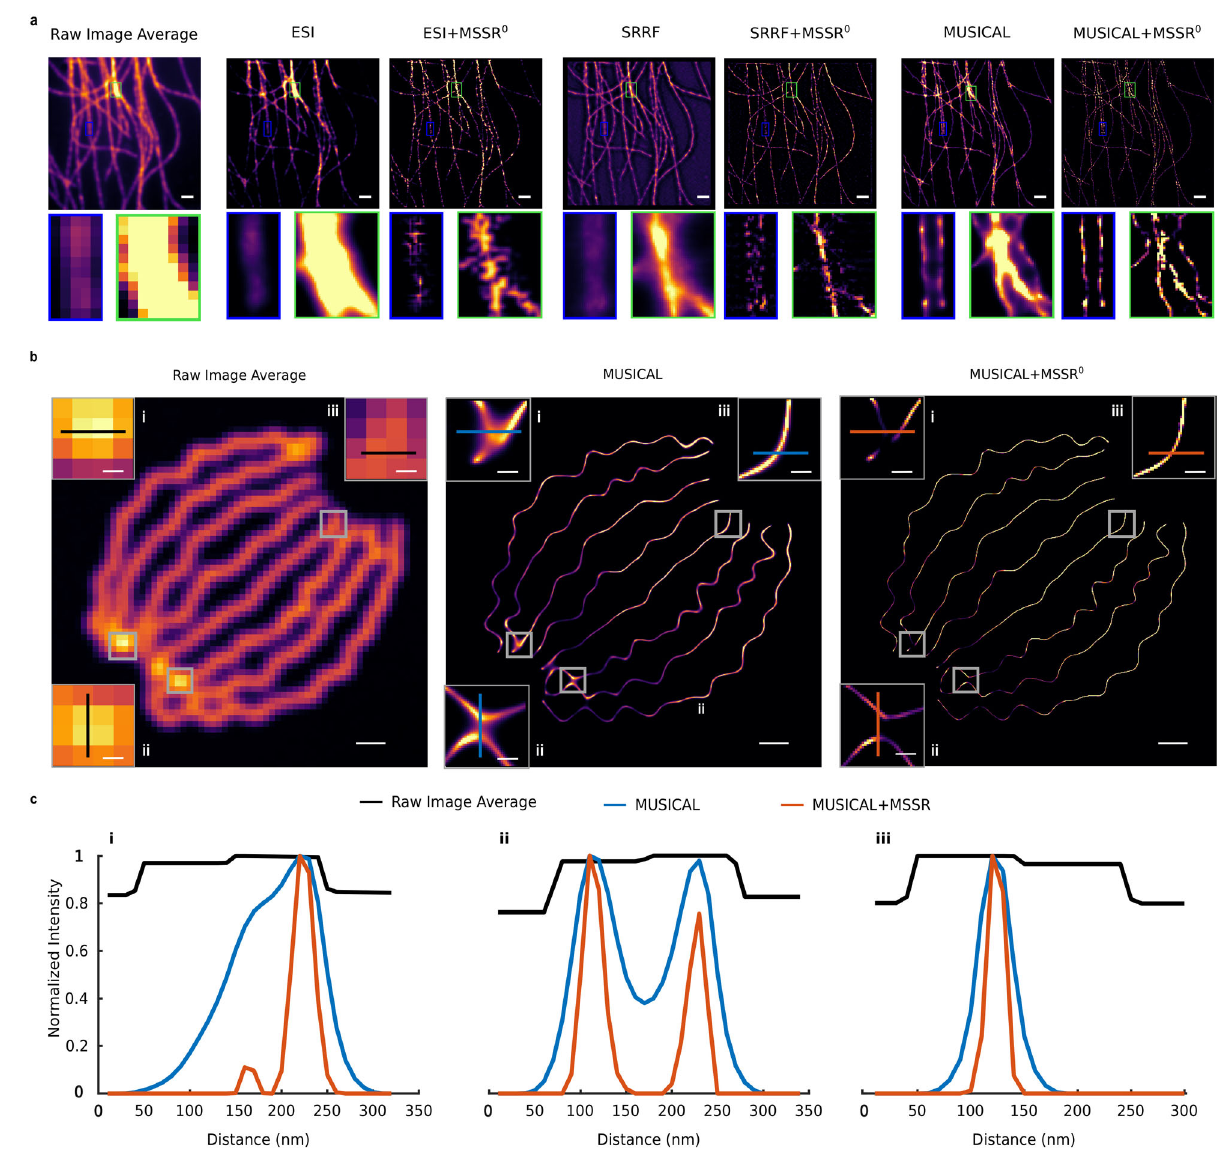
Fig.5|MSSRfurtherenhancestheresolutionandcontrastofSIMorpreviously super-resolved images. a Comparison of SRM results of ESI, SRRF and MUSICAL alone and after post-processing with MSSR 0 (ESI + sf-MSSR 0 , SRRF + sf-MSSR 0 , MUSICAL + sf-MSSR 0 ), over a temporal stack of 500 DL images of tubulin-labeled microtubules.TheaverageprojectionoftheDLstackisshownontheleftmostside. b Comparison of the increase in spatial resolution of MUSICAL with and without post-processing with MSSR 0 (MUSICAL + sf-MSSR 0 ), over a temporal stack of 361 DL images of modeled fl uorophores bounded to a synthetic array of nanotubes (average projection shown on left). The graphs show the intensity pro fi les along